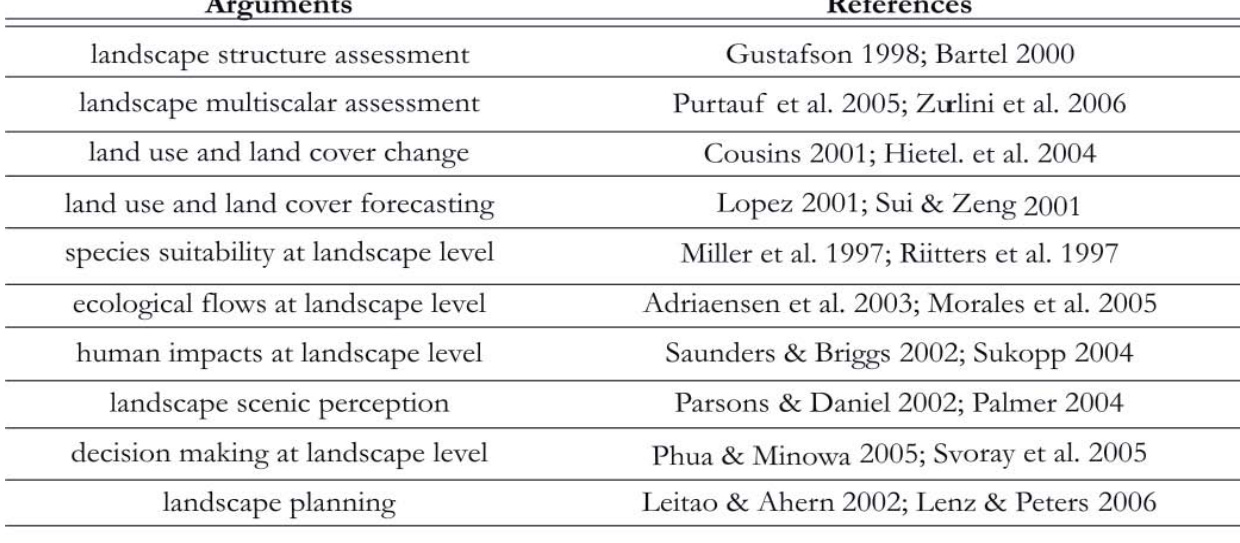
Table 1: A list of the most common arguments faced by landscape ecology during last ten years. For each subject, two significative references are